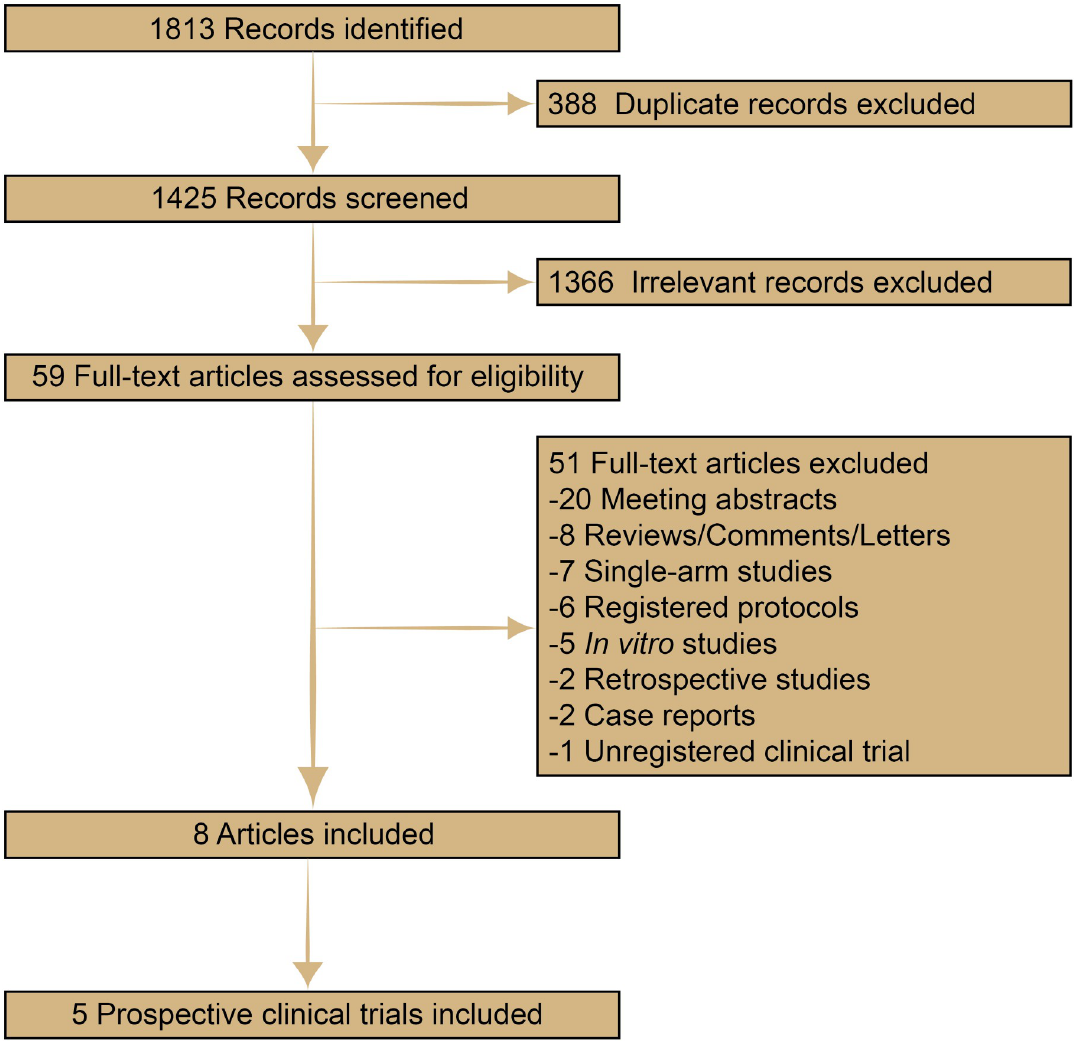
Fig 1. Flow chart of the selecting